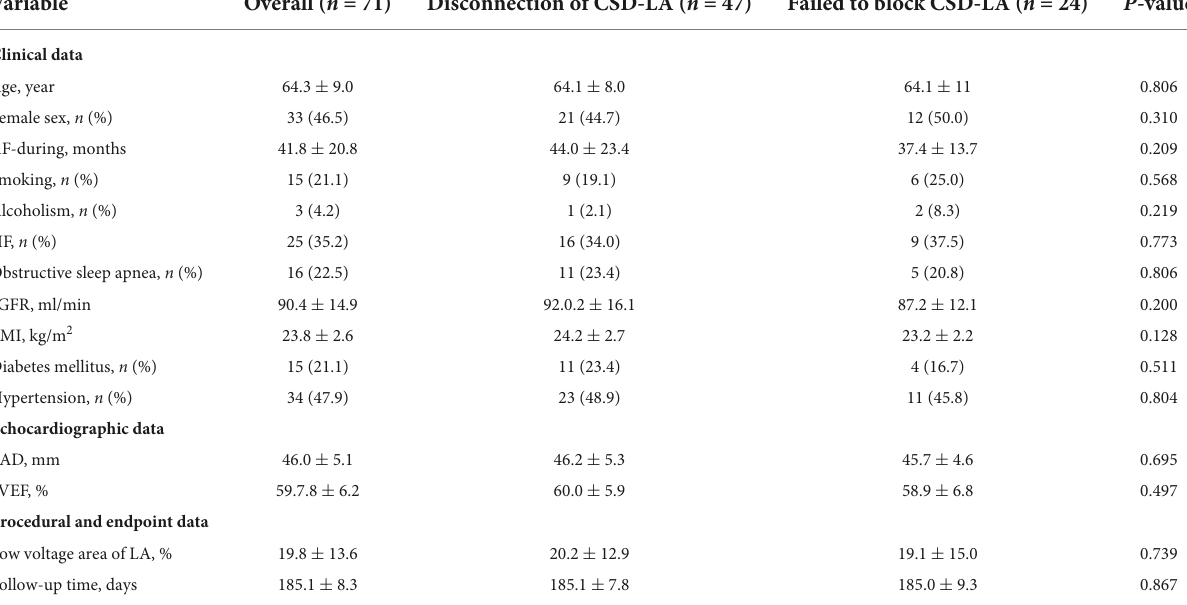
TABLE 1 Clinical characteristics, procedural data of the study’s cohort ( n =